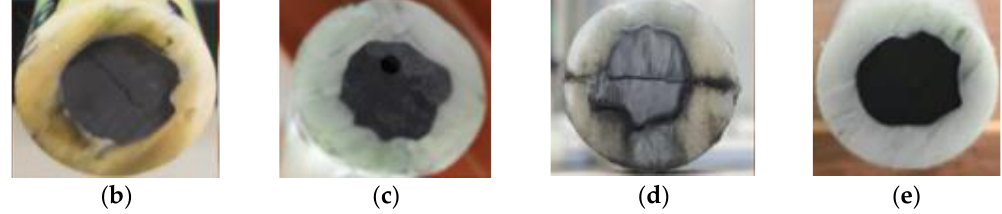
Figure 5. Carbon fiber sucker rod: ( a ) small crack defect, ( b ) transverse crack defect, ( c ) hole defect, ( d ) chapped defect, and ( e ) with no defect.